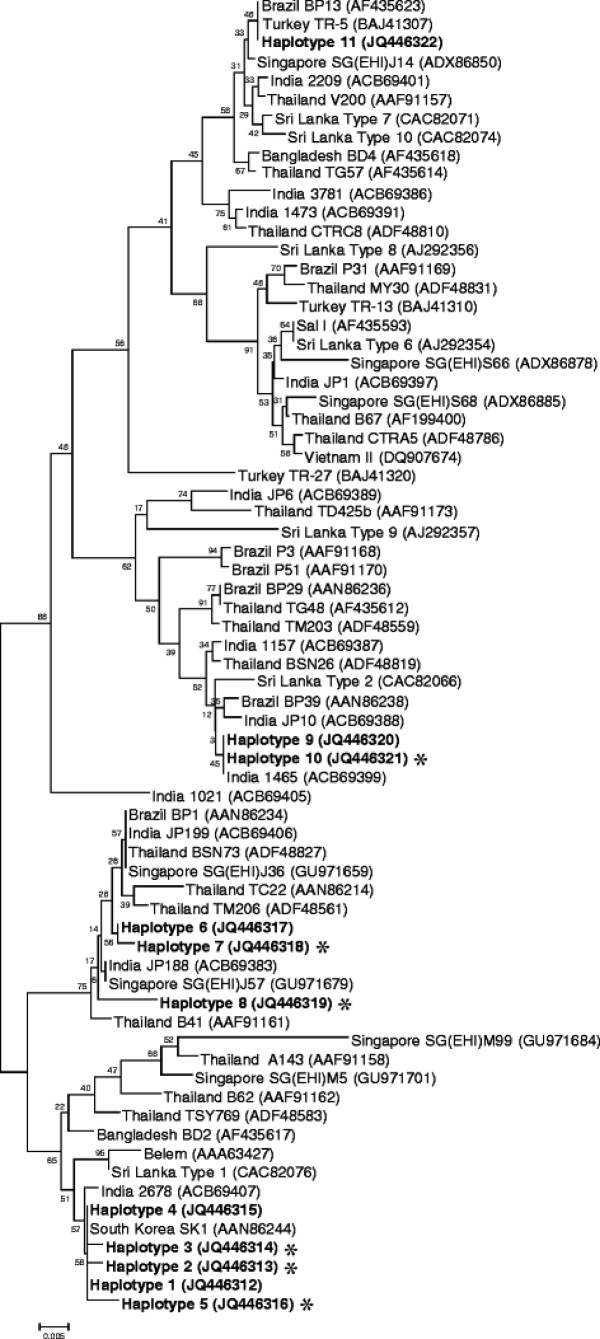
Phylogenetic analysis. The phylogenetic tree for the 11 haplotypes of PvMSP-142 was constructed using a neighbour-joining method with the MEGA4 program. Numbers on the branches indicate bootstrap proportions (1,000 replicates). The new haplotypes are marked with asterisks.